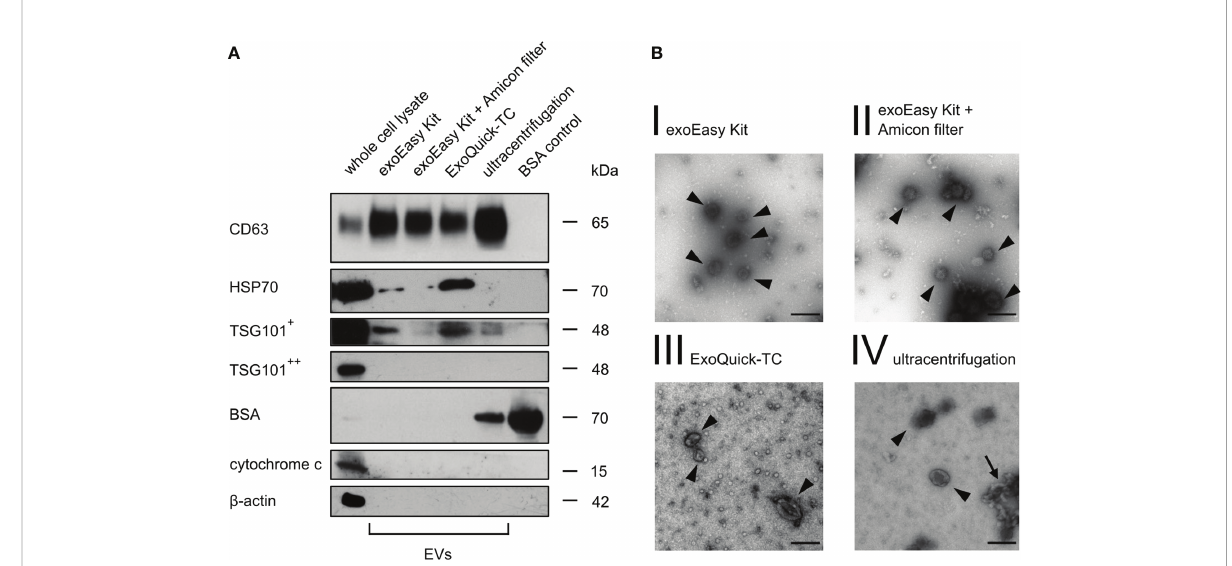
FIGURE 2 Westernblotandtransmissionelectronmicroscopy of MOLM-13-derivedEVs. (A) Westernblotanalysisof MOLM-13cellsandMOLM-13-derivedEVs (40 µg/lane)obtainedafterdifferentisolationmethods. AspositivevesiclemarkersCD63,HSP70, andTSG101wereanalyzed( + indicates long, ++ short exposuretime). Cytochrome cand b -actinserve asnon-EVmarkers. BSA(2µg/lane)wasused aspuritycontrolfornon-EVco-isolatingstructures. The shownWesternblot is arepresentative fi gureofn =3biological replicatesfromthreeindependentexperiments. (B) Transmissionelectron microscopy of MOLM-13-derivedvesiclesshowedEV-sizedcup-shapedstructuresforevery isolationmethod. Scale barintherightlowercornerwas setto150nm. The arrowheadsdisplayvesicle-likestructures, whereasthe arrowpointsout garland-likeclottedformations.